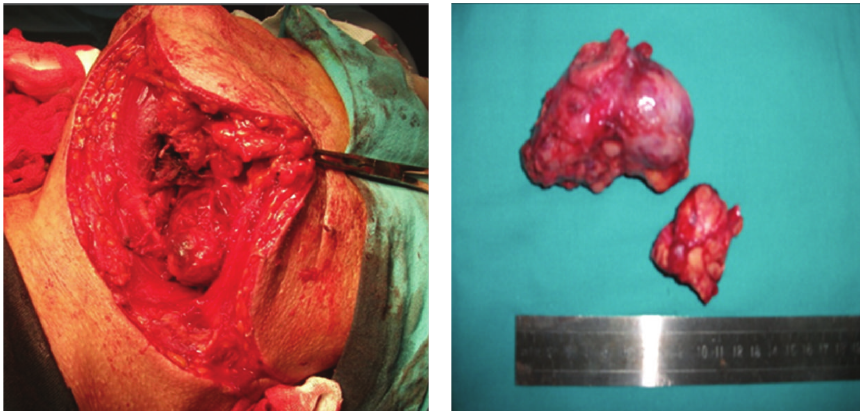
Figure 2: Intraoperative and gross feature of the mass.